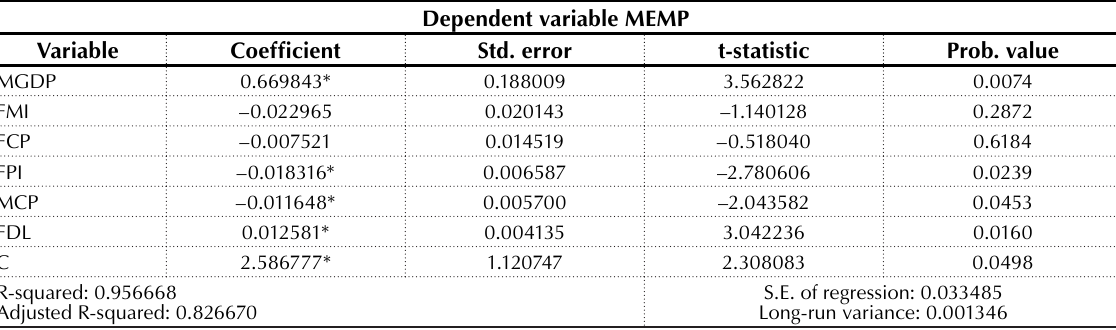
Source: Authors’ calculation from Eviews 9.5.